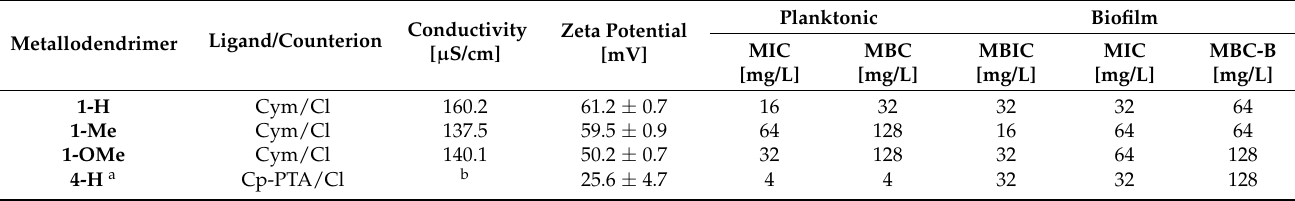
Table 2. Bacteriostatic and bactericide effect of first-generation carbosilane Ru(II) metallodendrimers in S. aureus planktonic cells (MIC, MBC) and biofilm-forming cells (MBIC, MIC, MBC-B).